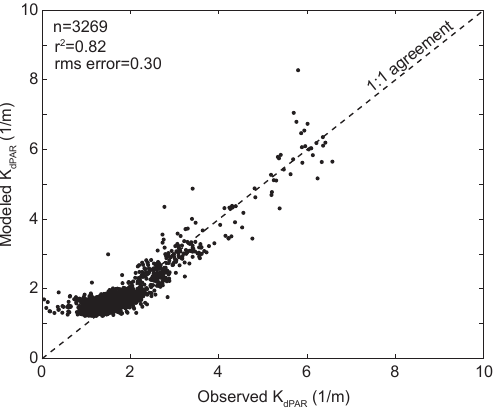
Figure 8. Agreement between observed K dPAR over the PAR spec- trum and the spectral attenuation model of Gallegos et al. (2011).